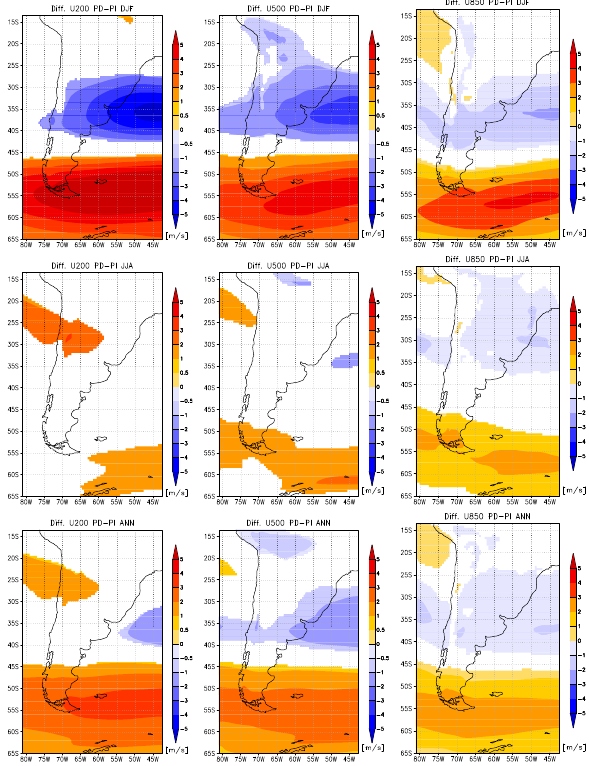
Fig. 7. Difference maps between the present-day and the pre- industrial period for zonal winds for different atmospheric levels at Figure 7 : Difference maps between the present-day and the pre-industrial period for zonal 200hPa (left row), 500hPa (middle panel) and 850hPa (right row). winds for different atmospheric levels at 200 hPa (left row), 500 hPa (middle panel) and 850 Results are displayed for austral summer (December–February, left hPa (right row). Results are displayed for austral summer (December–February, left column), column), austral winter (June–August, middle column) and the an- nual mean (right column). Only values statistically significantly dif- austral winter (June–August, middle column) and the annual mean (right column). Only values ferent at the 5% level are given (two-sided statistically significantly different at the 5% level are given (Two-sided t-test).